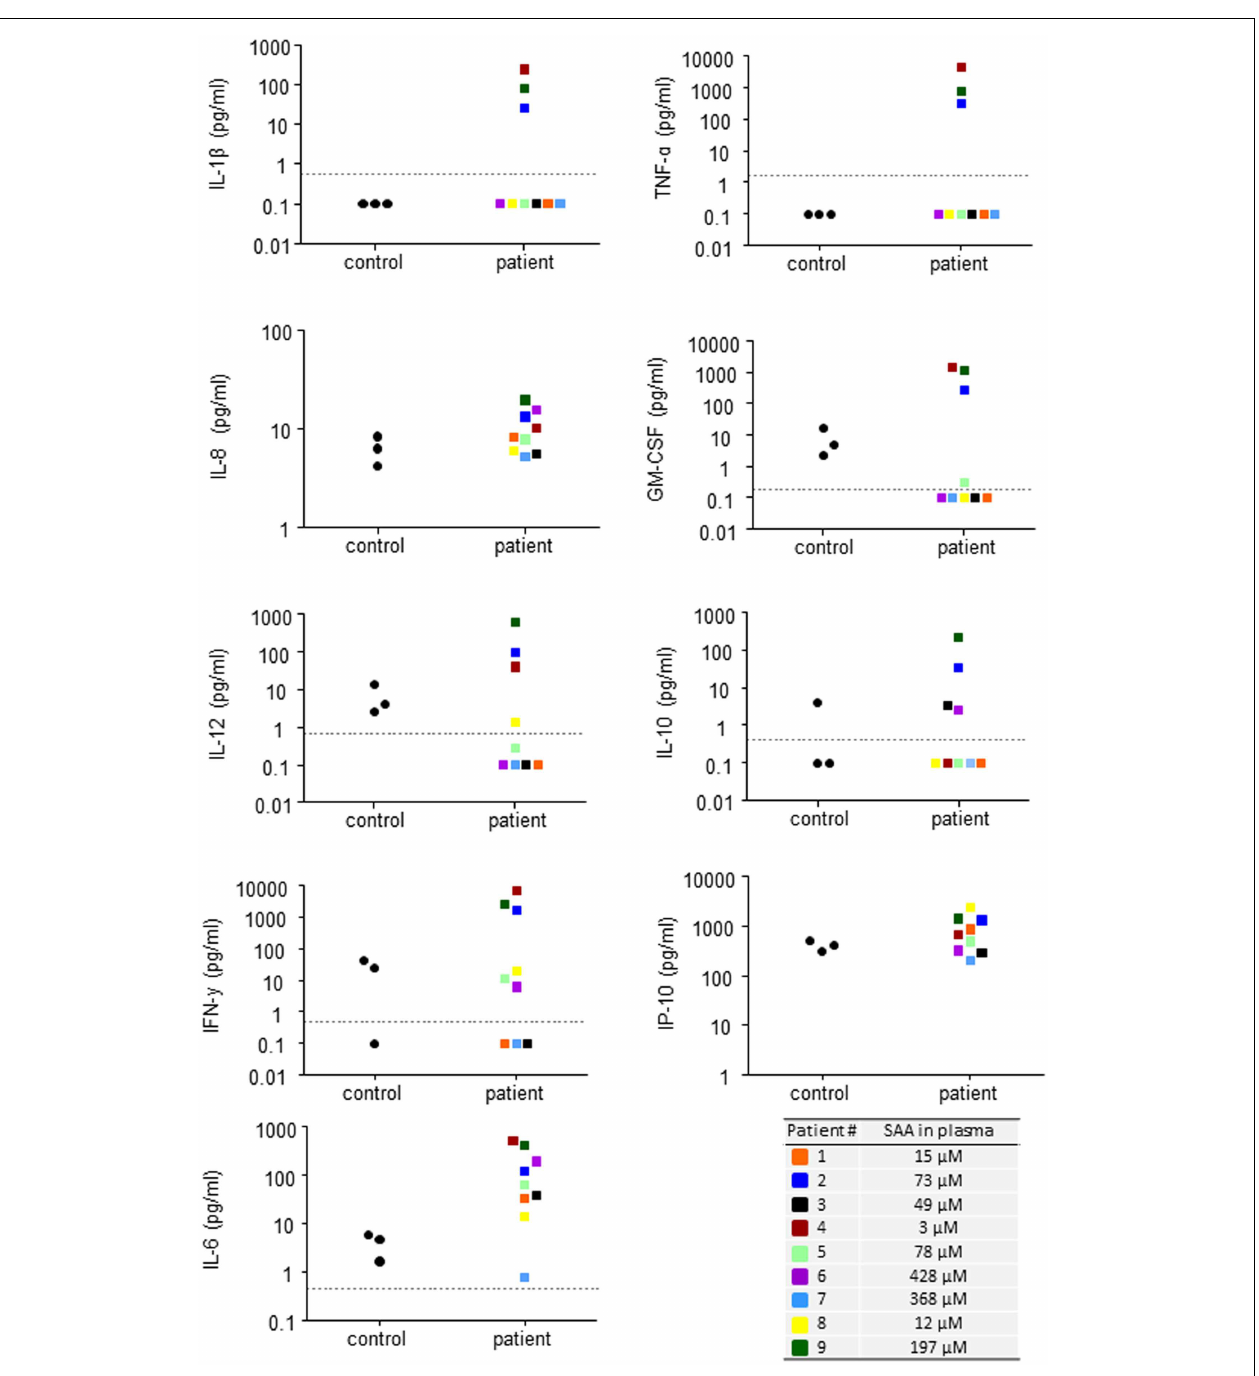
detection limits for each cytokine; samples lower than detection limit were given a value of 0.1pg/ml to facilitate presentation of data. Circulating SAA levels for each patient are shown (additional data in Table 1